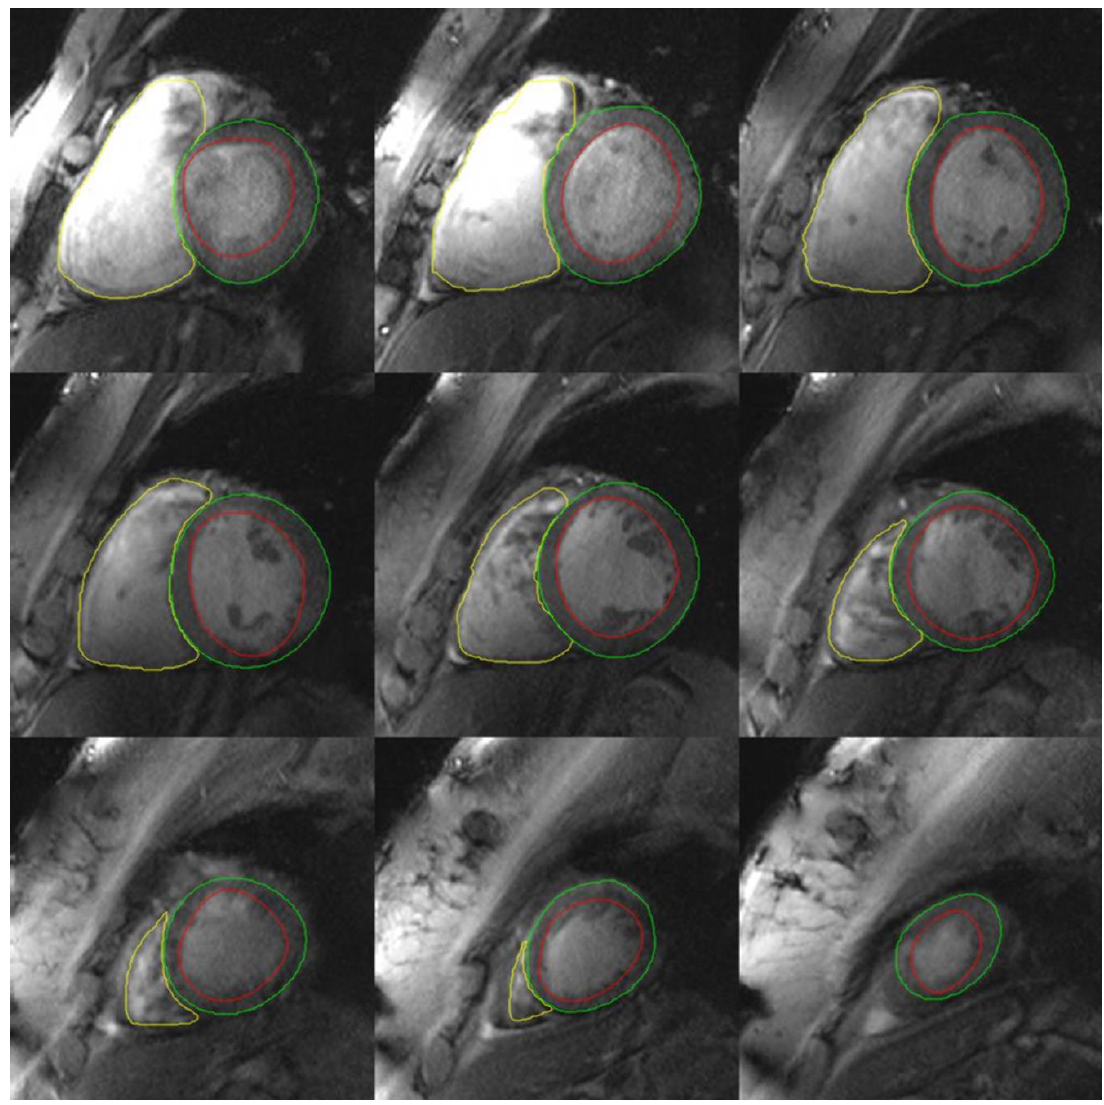
Figure 4. Quantitative volumetric analysis of left and right ventricular volumes from 7 T MRI. End-diastolic phase (red endocardial contour, green epicardial contour, yellow right ventricular contour). Note in the basal (top) slices there is bright signal in the right ventricular cavity due to coil inhomogeneity and proximity to the surface coil.